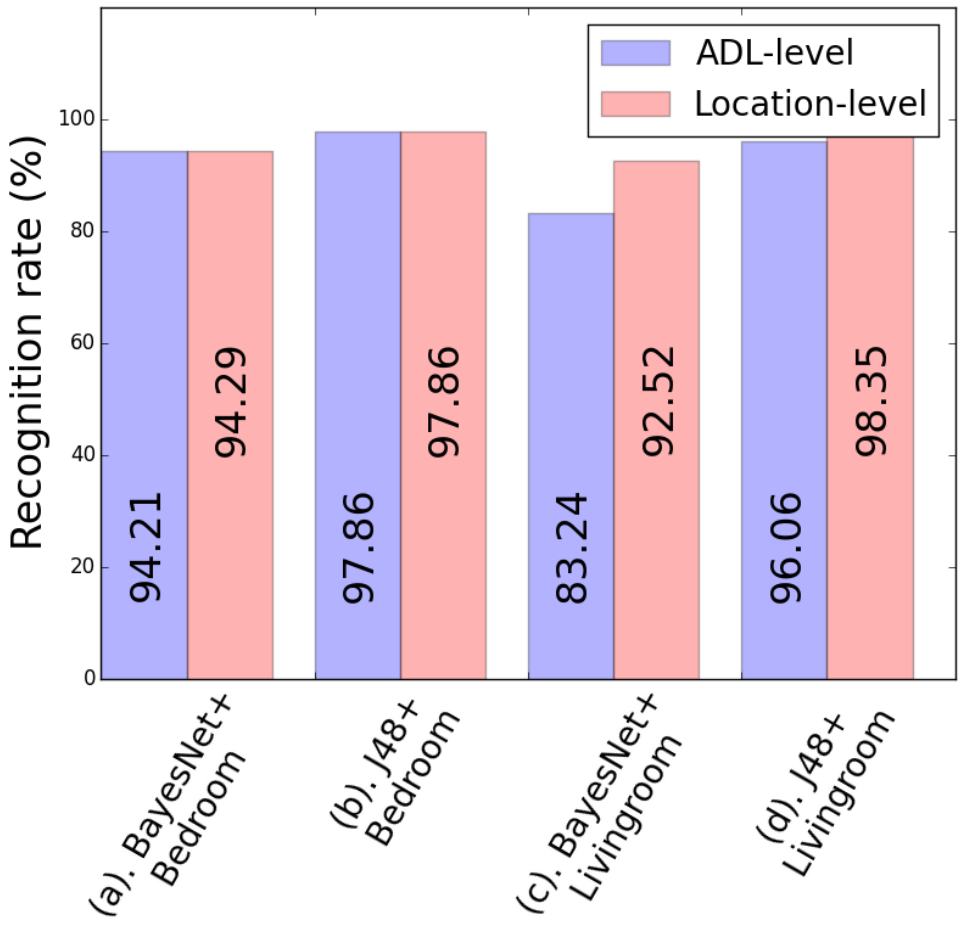
Figure 11. Recognition comparison in bedroom and living room under different kind of classifiers. “BayesNet” represents using a Bayesian network classifier and “J48” represents using a decision tree